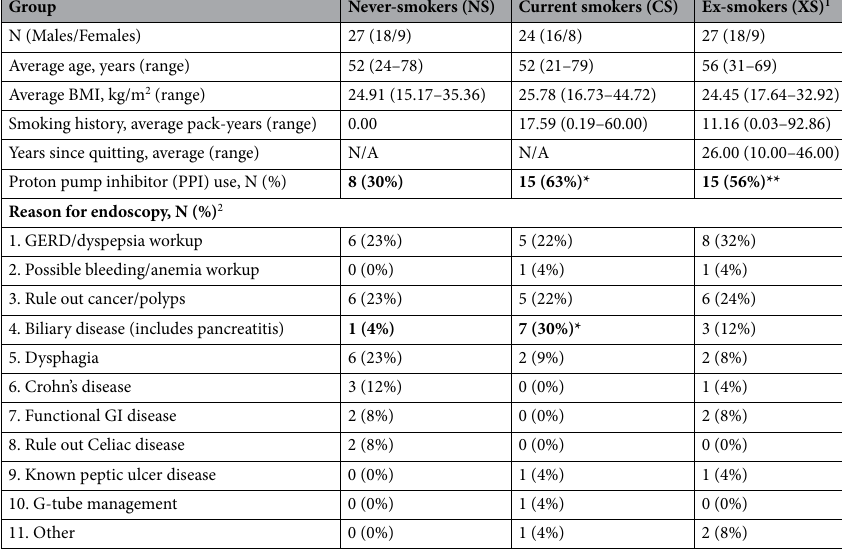
Table 1. Subject characteristics. 1 Ex-smokers had not smoked in the last 10 years. 2 Data available for 26 NS, 23 CS, and 25 XS subjects. Significant differences are shown in bold. * denotes significant differences between CS and NS, and ** denotes significant differences between XS and